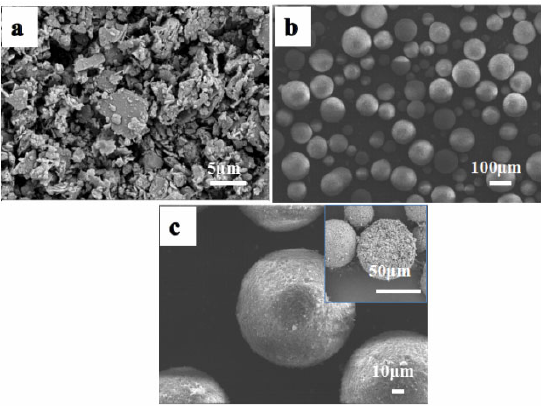
Fig. 2 SEM images and particle size distribution of raw coal gangue and green microspheres: (a) raw coal gangue, (b, c) green